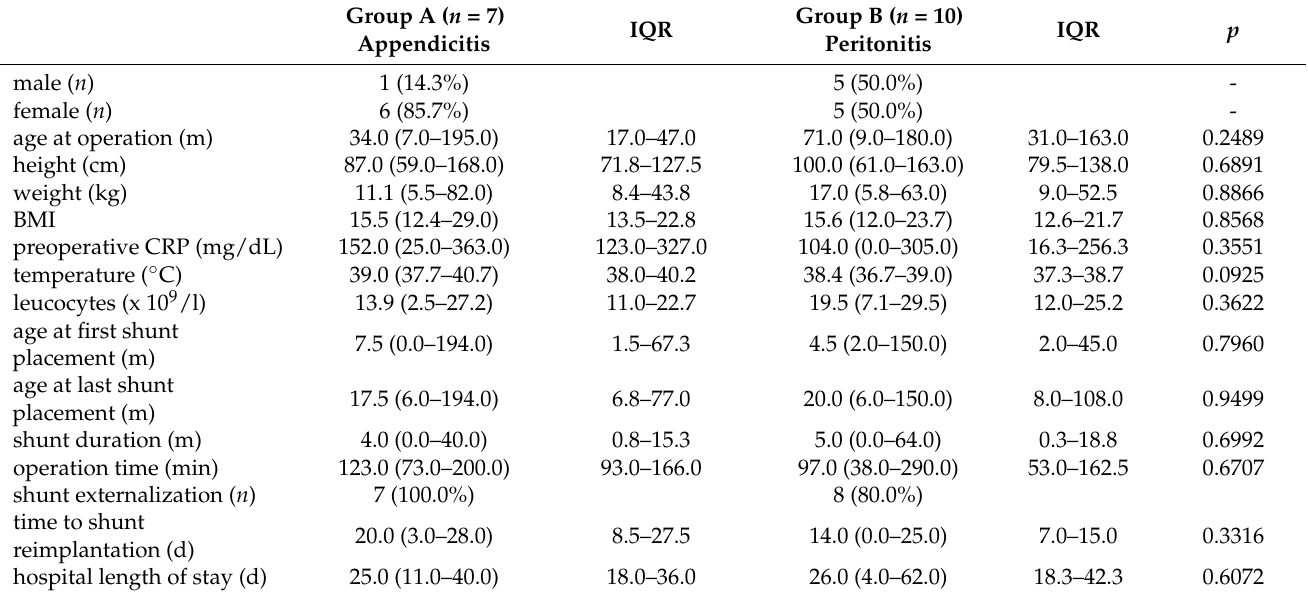
Table 1. Patient characteristics. BMI (Body mass index), CRP (C-reactive protein), IQR (inter quartile